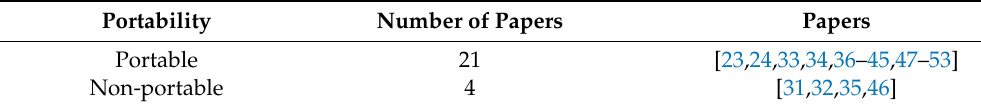
Table 7. Portability of devices presented in the papers.